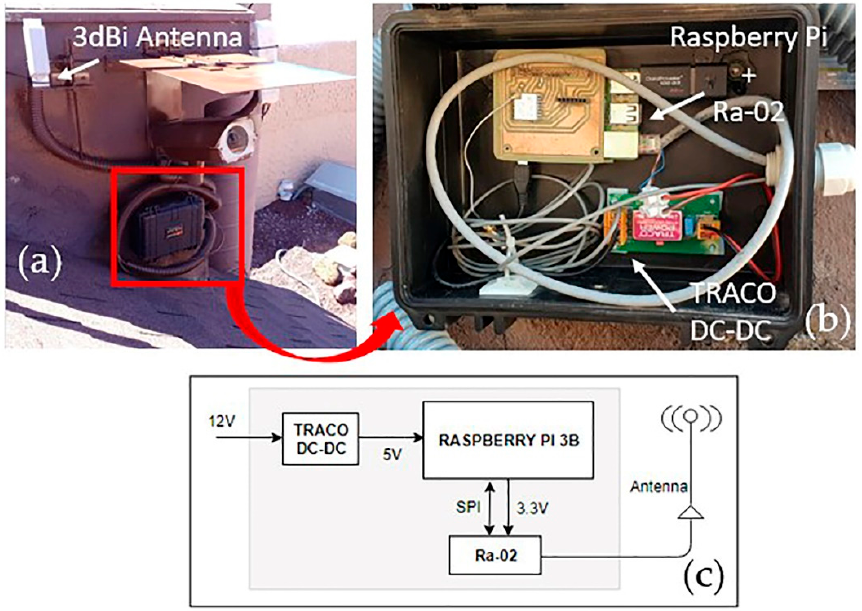
Figure 3. Gateway. Configuration ( a ) and ( b ) and general hardware scheme ( c ).